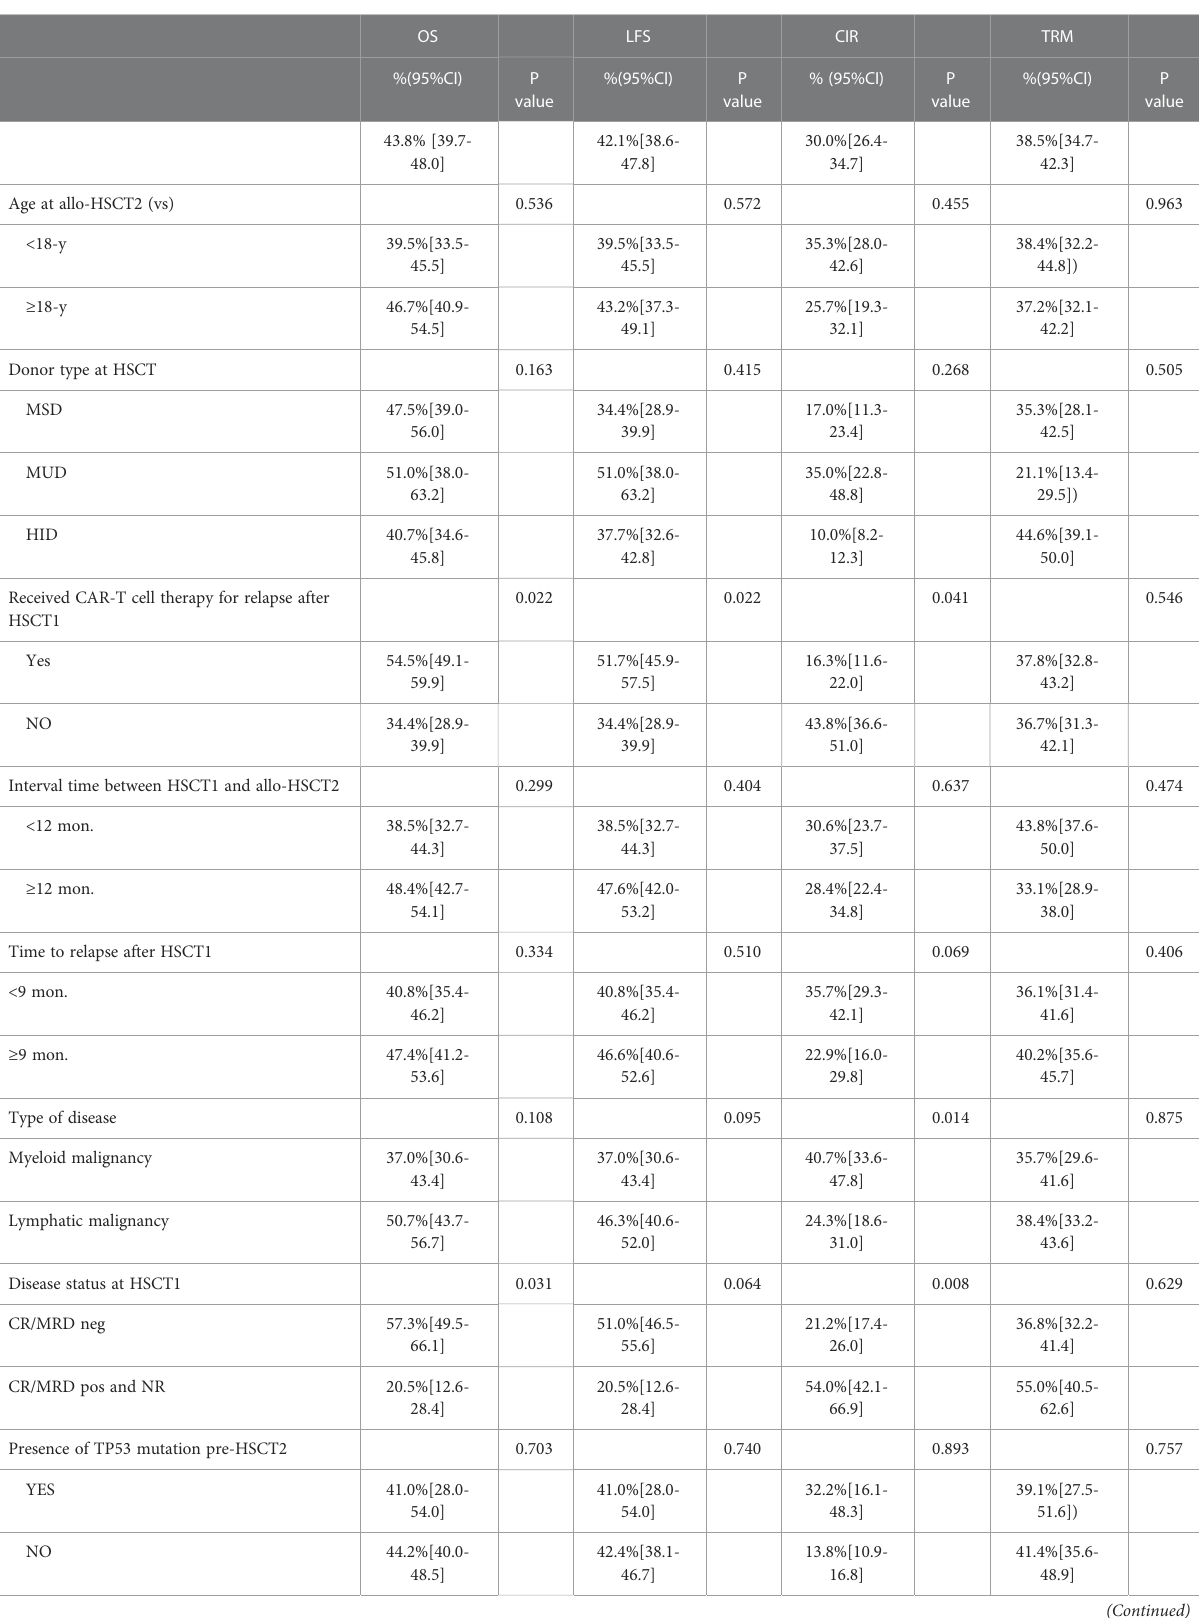
TABLE 3 Univariate analysis of pre-allo-HSCT2 variables associated with outcomes